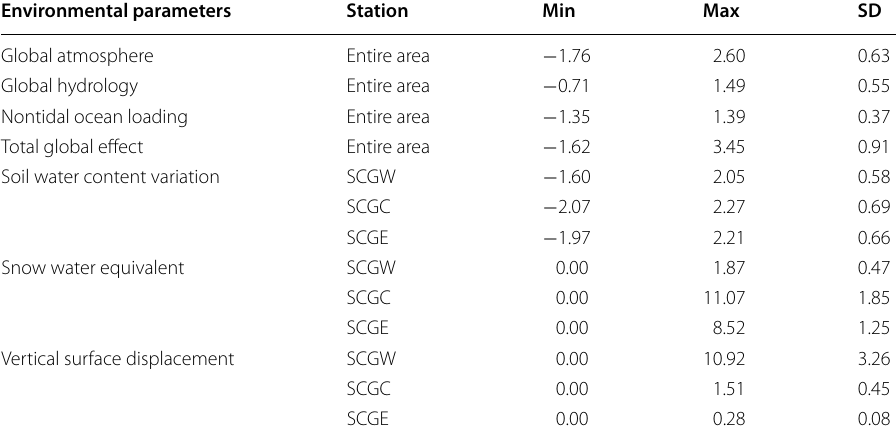
soil water content variations, snow water equivalent and vertical surface